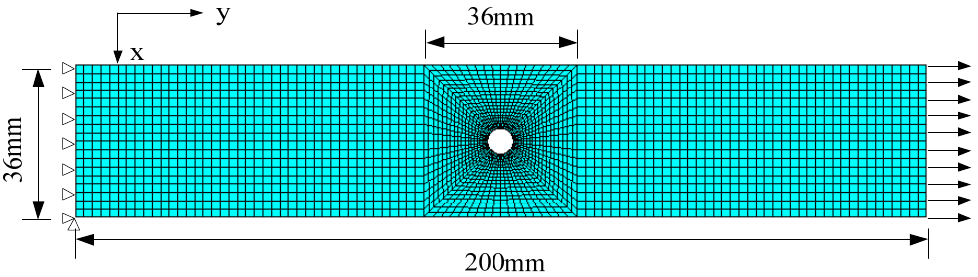
Figure 2. Geometrical size and mesh of finite element (FE) model. Table 2. Elastic properties of shell element in FE model [1].